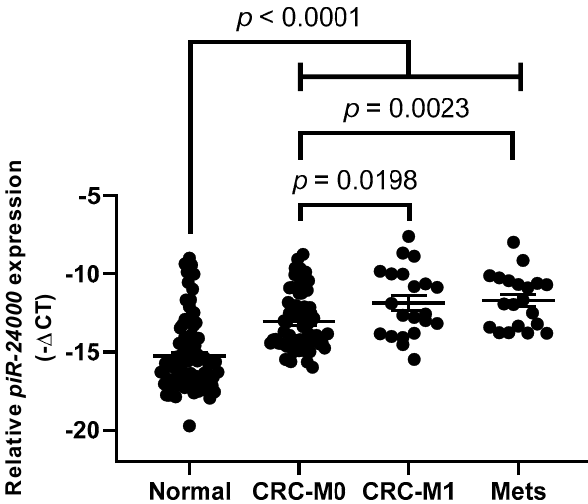
Figure 4. Expression of piR-24000 in normal colonic mucosa and metastatic subtypes of CRC. Real-time PCR-based expression analysis of piR-24000 in normal colonic tissue ( N = 87), non-metastatic CRC tissue (CRC-M0; N = 66), metastatic CRC tissue (CRC-M1; N = 21), and distant liver metastases (Mets; N = 20). Expression of piR-24000 was normalized to RNU6B and expressed as −∆ Ct (negative delta Ct).